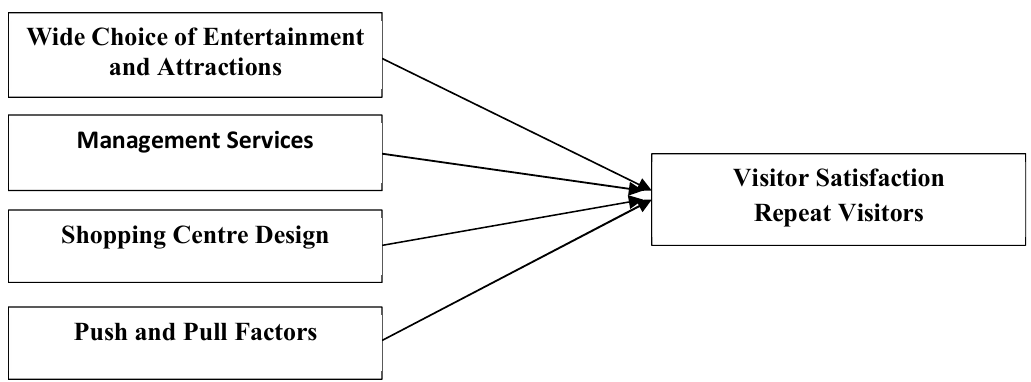
Fig. 1. Conceptual Framework. Source: Hashed,